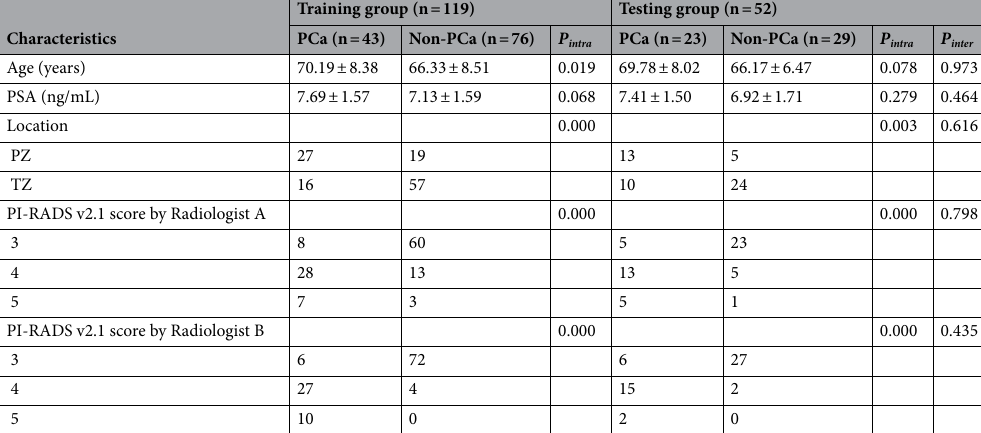
Table 1. Patients’ characteristics in the training and testing groups. Note. PCa, prostate cancer; Non-PCa, Non-prostate cancer; PSA, prostate serum antigen; PZ, peripheral zone; TZ, transition zone. The assessment of PI-RADS v2.1 was performed by two radiologists, a junior with 5 years of experience (Radiologist A) and a senior with more than 20 years of experience (Radiologist B) in urogenital imaging. P intra is the result of univariate analysis between PCa and Non-PCa while P inter represents whether a significant difference exists between the training and testing